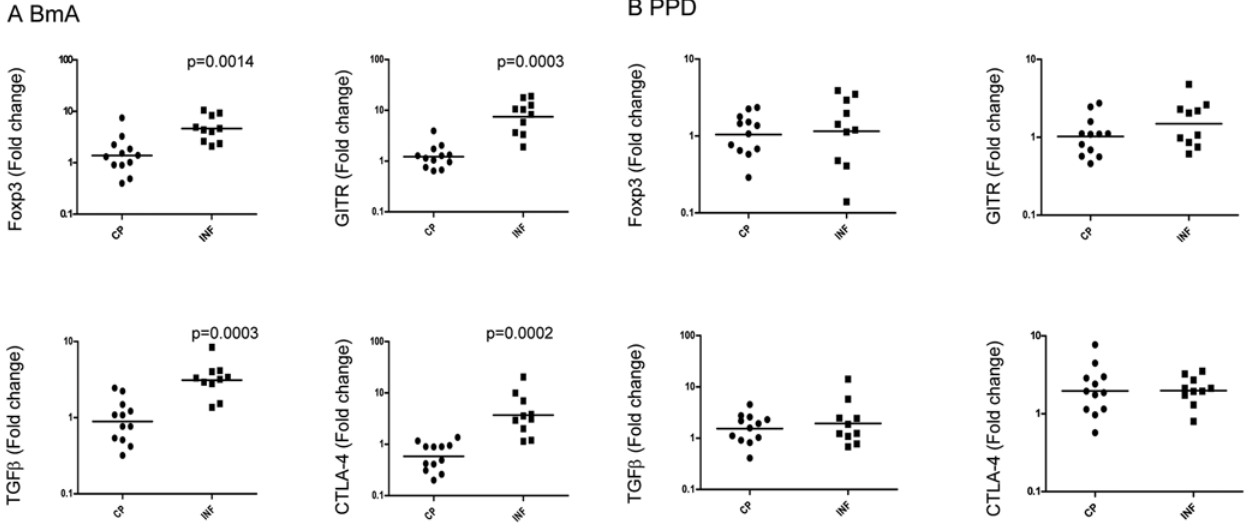
Figure 4. Filarial lymphedema is associated with lack of Foxp3, GITR, TGF b , and CTLA-4 upregulation. (A, B) PBMCs from filarial lymphedema [CP] (n=12) and asymptomatic infected [INF] (n=10) patients were stimulated with (A) BmA (10 m g/ml) or (B) PPD (10 m g/ml) for 24 hours, and Foxp3, GITR, TGF b , and CTLA-4 mRNA were measured by real-time RT-PCR. Results are shown as fold change over media control. P values were calculated using the Mann-Whitney test.